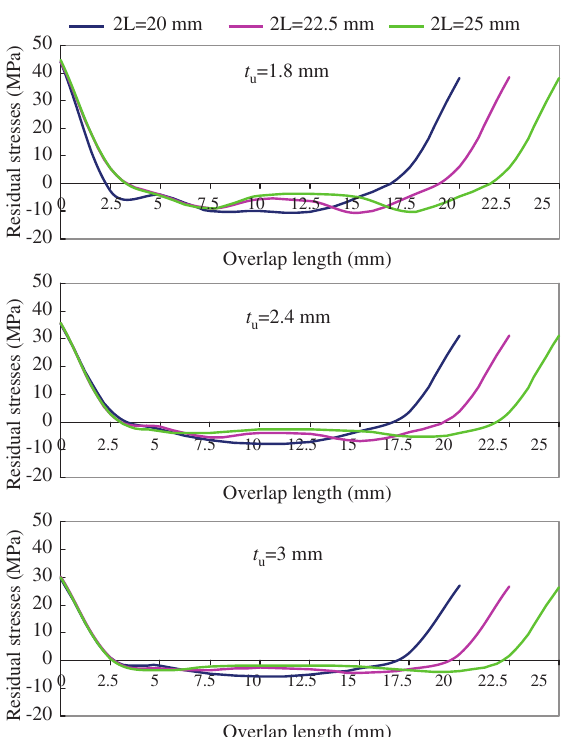
Figure 14 Effect of adhesive length on the residual shear stress for adhesive thickness of t